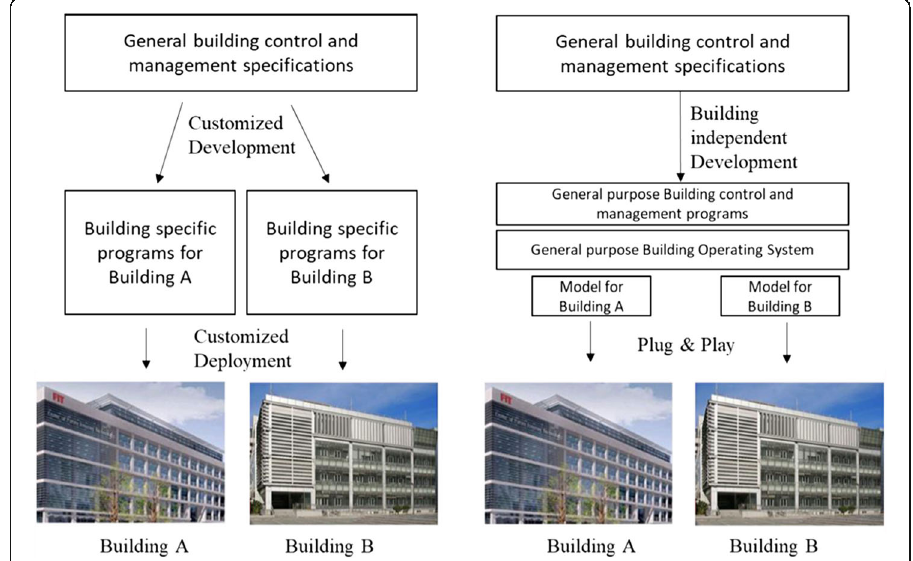
Fig. 3 a Customized Building Control System (left). b New Platform of Building Control System